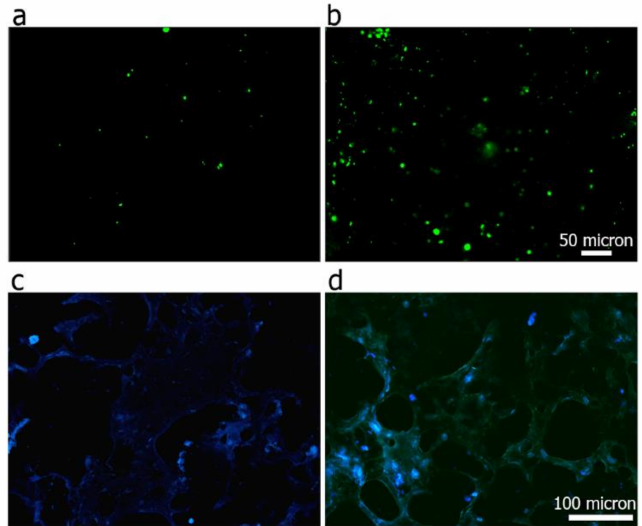
Figure 6. Cell viability of 3T3s after 24 h of culture on PVA ( a ) and gelatin/PVA ( b ) hydrogel film. Green spots are alive cells, red spots are dead ones. DAPI staining on histological sections representing nuclei (blue staining) of 3T3s adhering over the 3D porous PVA hydrogel ( c ), and composite porous gelatin/PVA hydrogel ( d